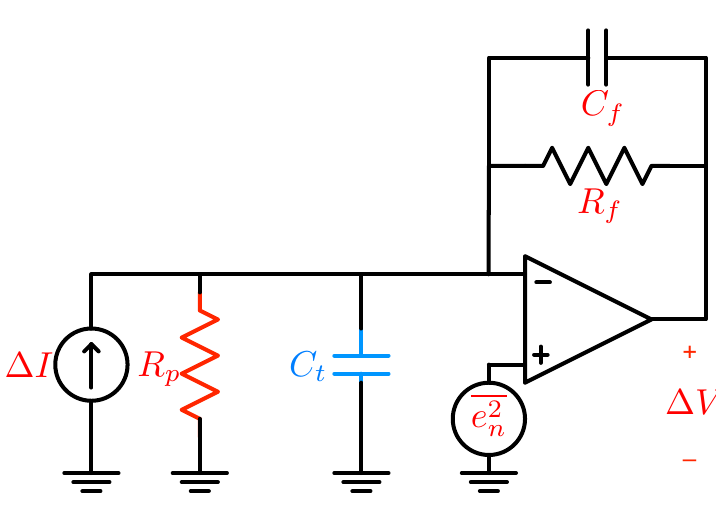
Figure 22. Basic transimpedance amplifier (TIA) implementation.